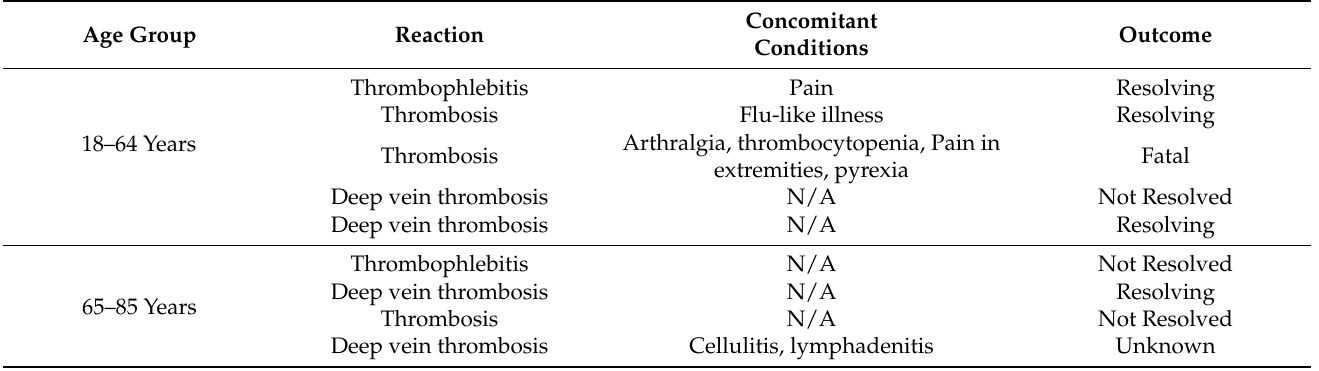
Table 4. Type of thromboembolic reaction and clinical outcome for male cases by age group ( N = 9/28). Age